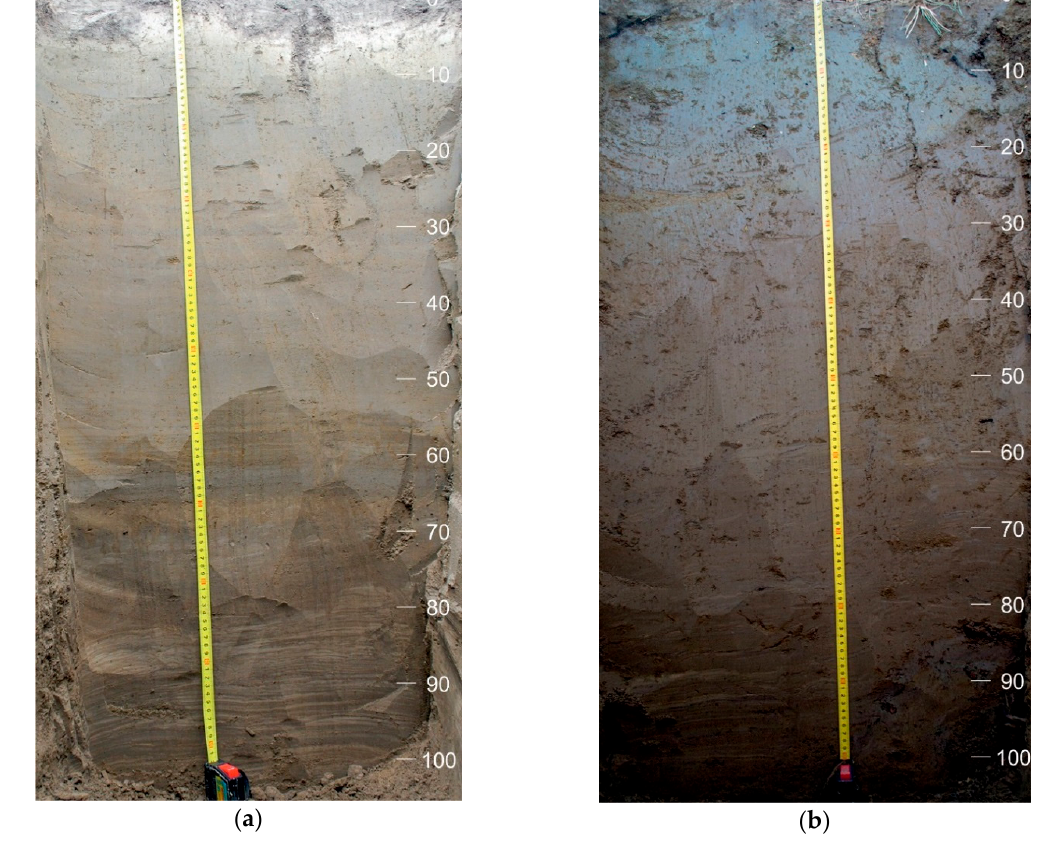
Figure 4. Soil profiles of the frozen alas steppe ( a ) and meadow ( b ) soils.